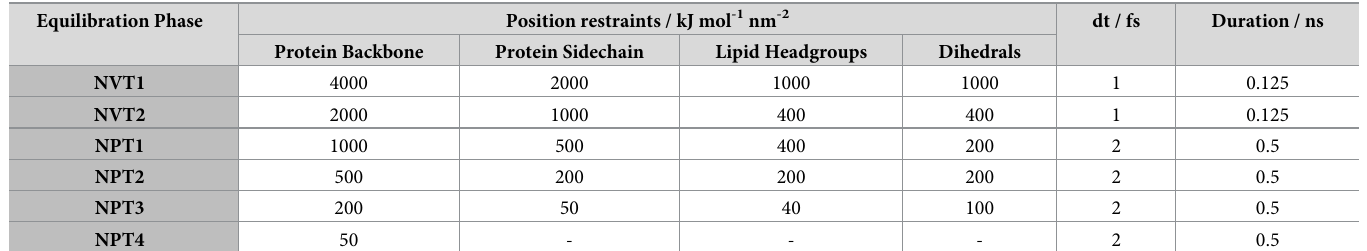
Table 3. Position restraints, timestep, and duration of the equilibration phases.